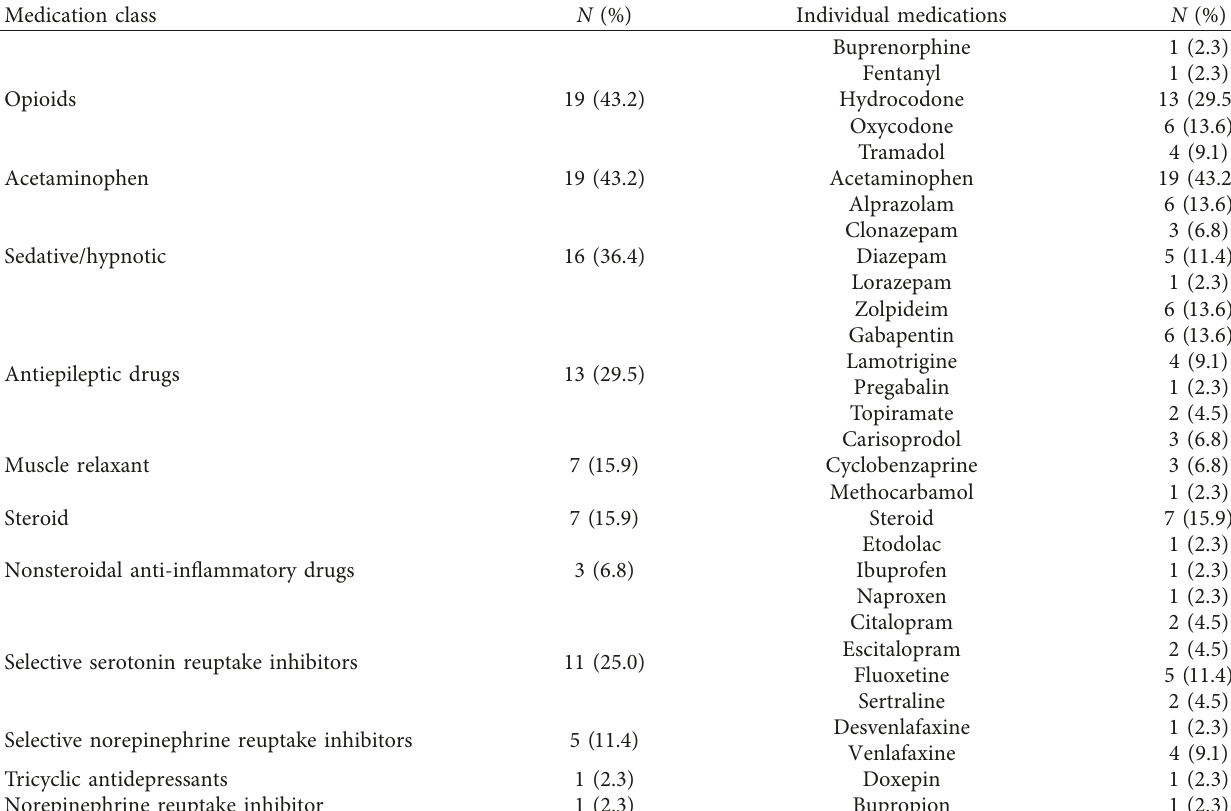
Table 2: Medication exposures among pregnant women with chronic pain